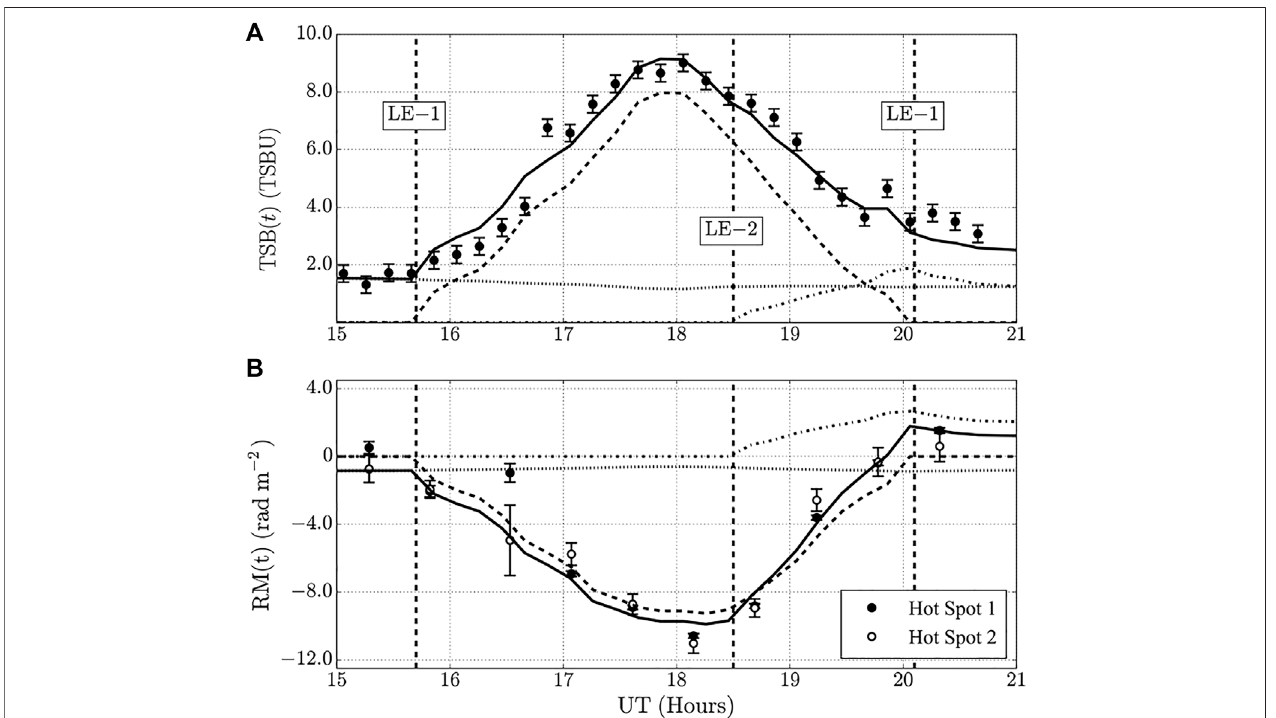
FIGURE6| Thomson-scatteringbrightness(TSB, (A) )andFaradayrotationmeasure(RM, (B) )throughCMEsusingaradiogalaxyasthebackgroundradiosource, as reported in Kooi et al. (2017). The 2012 August 2 event was modeled assuming occultation by two CMEs; LE-1 is the leading edge of the fi rst CME and LE-2 is the leadingedgeofthesecond. LE-1 at15:42UTand20:06UTmarkthebeginningandendingofoccultationbythe fi rstCME,respectively.Thedotted,dashed,anddash- dotted lines represent the coronal contribution, the fi rst CME ’ s contribution, and the second CME ’ s contribution, respectively. The solid black line gives the combined effect. The radio source provided two closely-spaced LOS labeled as Hot Spots 1 and 2. These data correspond to values reported for 2012 Aug. 2 e,f in Table 3 . This appears as Figure 10 in Kooi et al. (2017), ©Springer, reproduced with